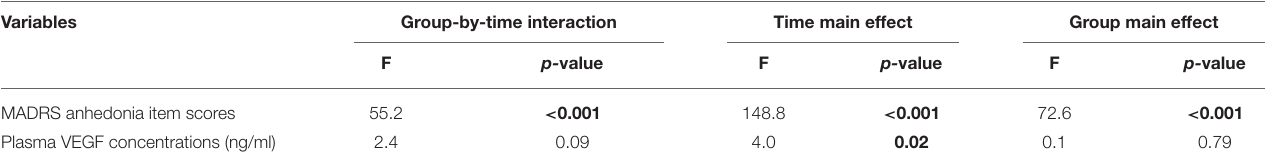
TABLE 2 | Comparison of MADRS anhedonia item scores and plasma VEGF concentrations between antianhedonic responders and non-responders in subjects suffering from TRD using linear mixed models. Variables Group-by-time interaction Time main effect Group main effect F p- value F p- value F p- value MADRS anhedonia item scores